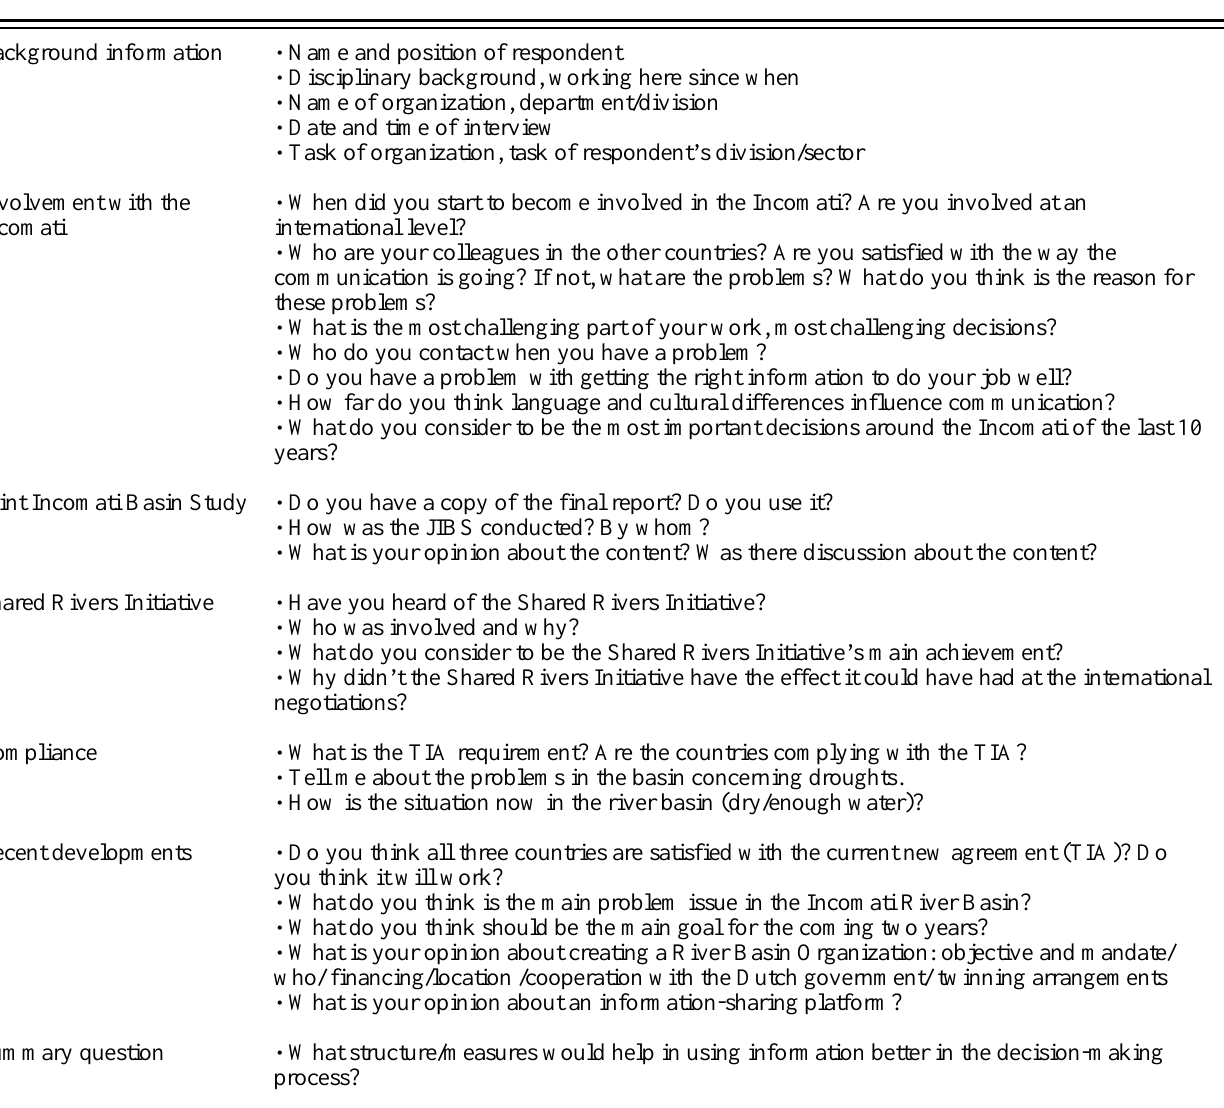
Table 3. List of interview